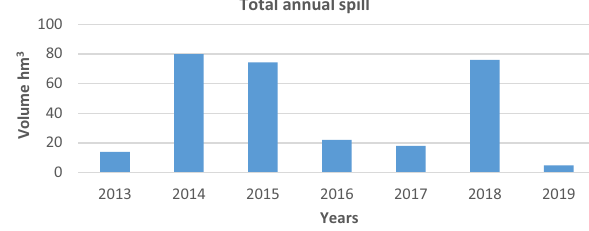
Fig. 12 Historical spills in Tuxpan diversion dam